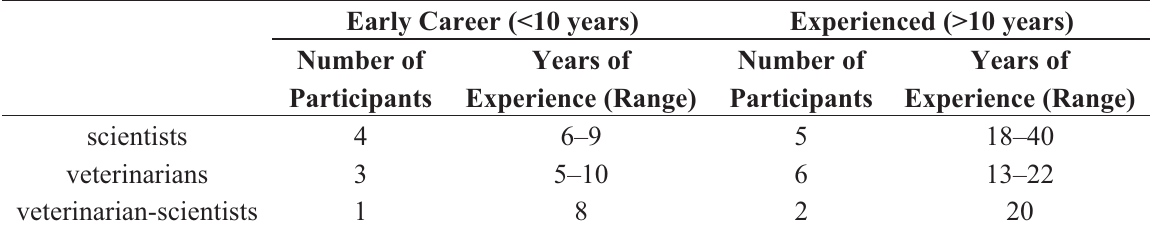
Table 1. Participants’ length of professional experience in animal-based